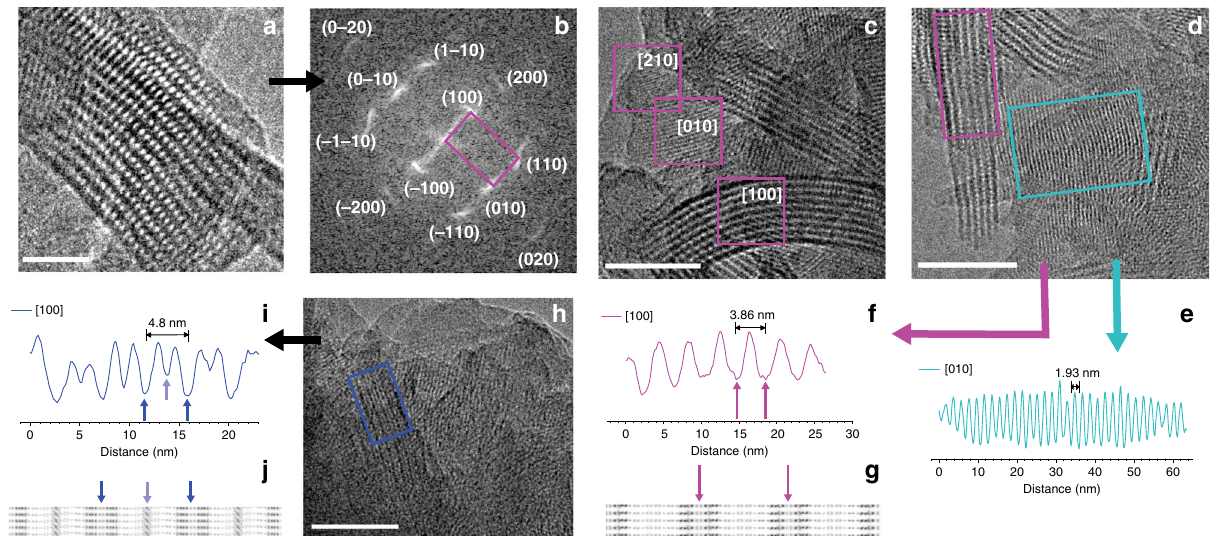
Fig. 6 TEM analysis. a A PY 2 B-COF crystallite viewed along [001] showing the pores in the structure. b Fast Fourier Transform (FFT) fi ltered image of a showing the different planes in the PY 2 B-COF crystallite in accordance with the PXRD data. c Individual crystallites of PY 2 B-COF in different orientations. Multiple lattice spacings can be identi fi ed as shown. d Individual crystallites of PT 2 B-COF in different orientations. e Line scan analysis in the [010] direction corresponding to the turquoise outlined region in d . A small d -spacing of 1.93 nm can be identi fi ed and is similar for all four COFs showing a similar constitution of the ribbon structure. A line scan analysis with monomodal intensity variation in the [100] direction (magenta outline) is shown in f . The magenta arrows correspond to the electron rich ribbons in PT 2 B-COF as shown with magenta arrows in the projected potential map g of the COF. Dark contrast corresponds to higher projected potentials. h Individual crystallites of PT-COF in different orientations. Multiple lattice spacings can be identi fi ed. A line scan analysis in the [100] direction (blue outline) showing bimodal intensity variation is shown in i . The deep blue arrows correspond to the electron rich ribbons in PT-COF as shown with similar arrows in the projected potential map j of the COF, wherein dark contrast corresponds to higher projected potentials. The light blue arrow in the line scan analysis designates the bi-coordinating P linkers in PT-COF, which are more electron rich than the B linkers in PT 2 B- and PY 2 B-COFs. Scale bars: a : 20 nm; c , d , h : 50